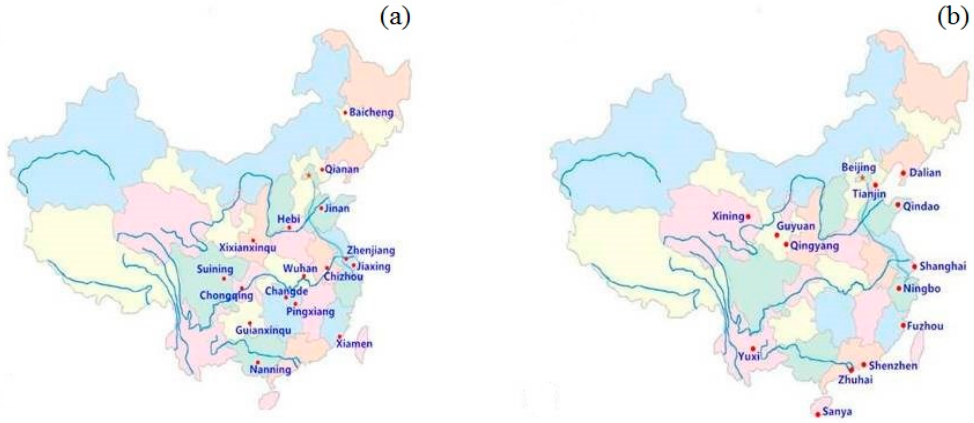
Figure 1. The Geographical distribution of model sponge cities in china; ( a ) Phase 1, ( b ) Phase